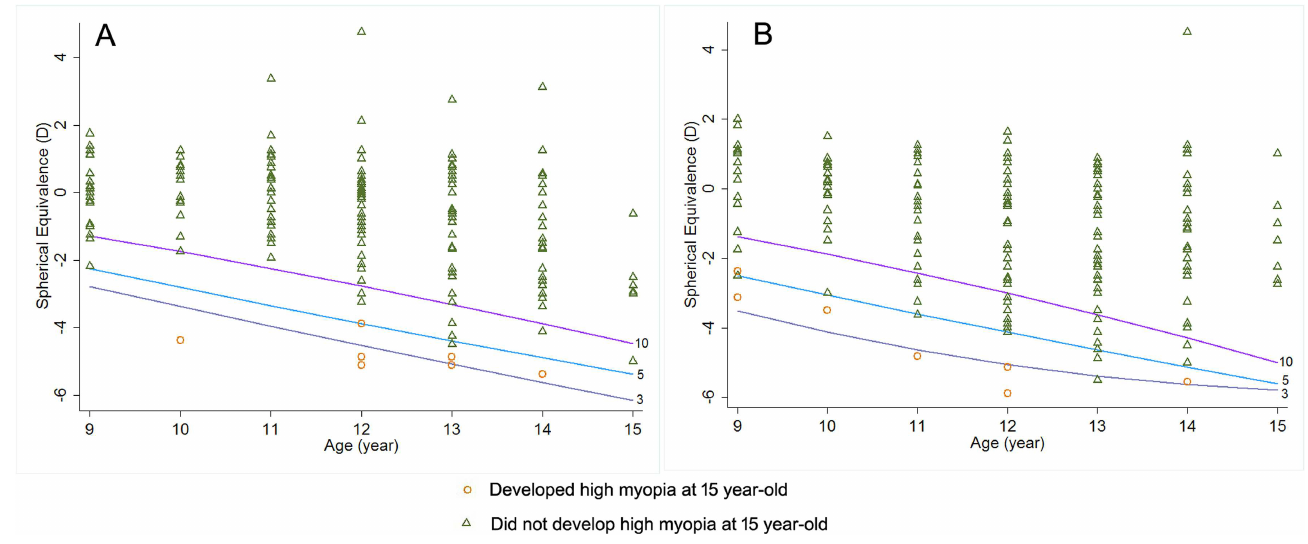
Fig 3. Distribution of age-specific spherical equivalent at baseline and classification of future high myopia onset at 15 yearsold among first-born twins. A for boys, B for girls. * Centilecurves were the ones constructed basedon cross-sectional data.